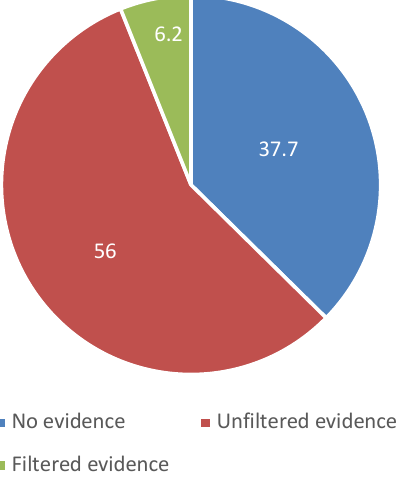
Figure 7: Evidence of the Problem (Average score %)